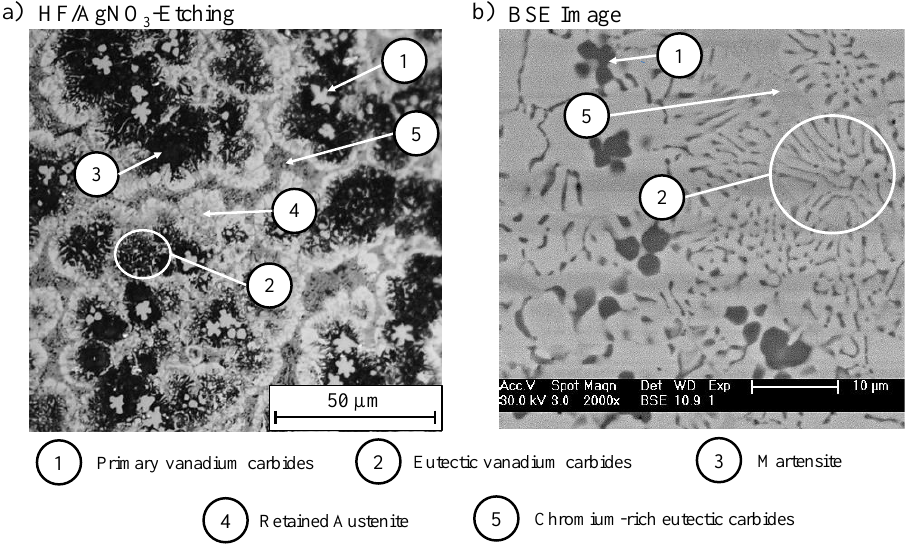
Figure 7. Microstructural characteristics of the FeV12 hardfacing and comparison between ( a ) light microscopy and ( b ) backscatter electron microscopy. Table 2. Electron dispersive X-ray analysis (EDX) measurements of the examined positions illustrated in Figure 7.